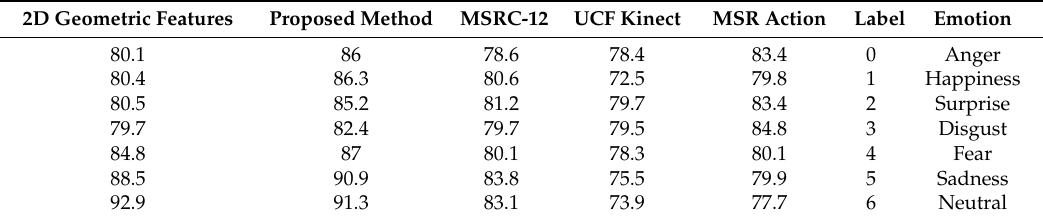
Table 8. Recall comparison for multimodal emotion recognition.